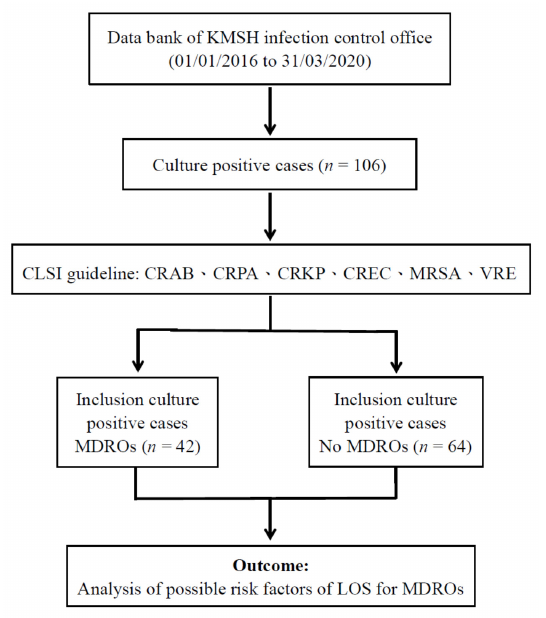
Figure 1. Experimental flow chart.